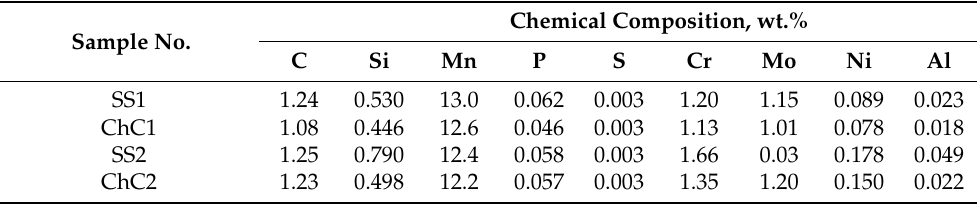
Table 2. The chemical composition of the investigated parts (optical emission spectroscopy). Sample No.